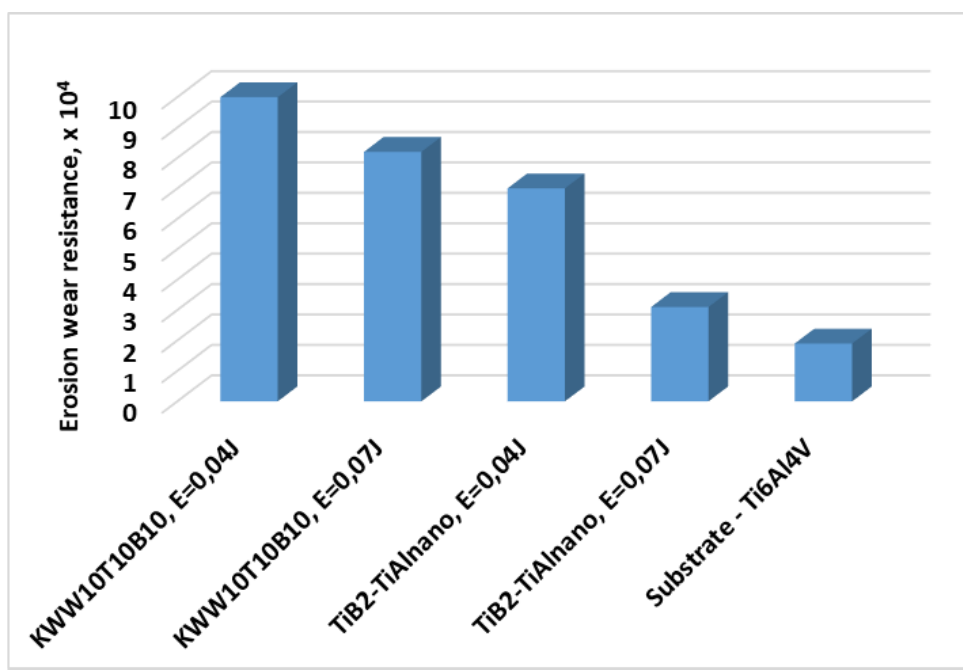
Figure 9. Wear resistance of the tested coatings (erosive wear).